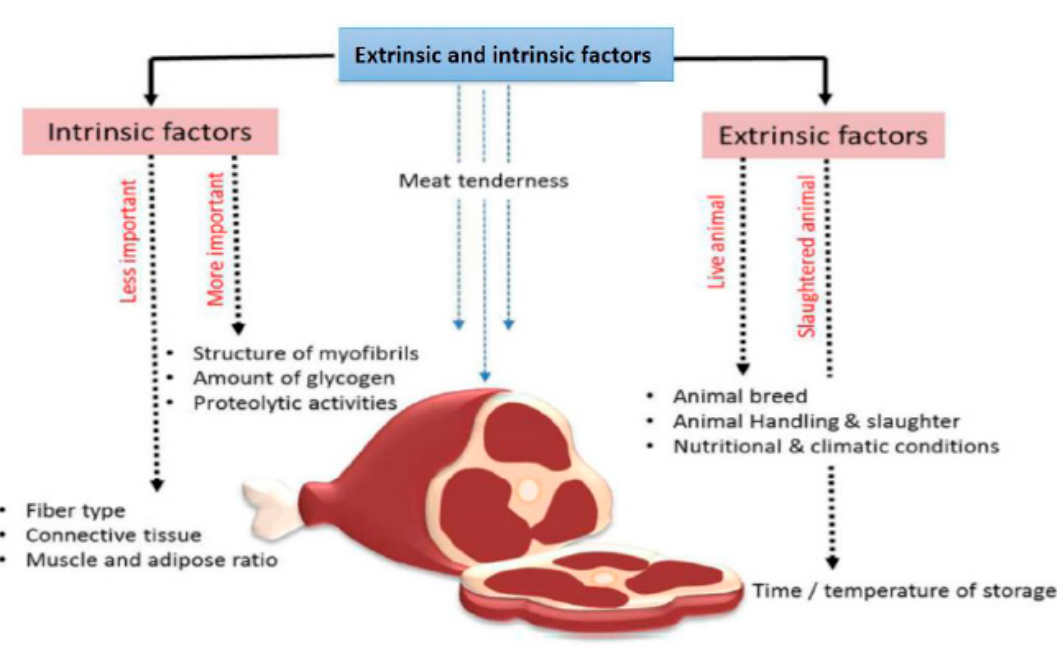
Figure 1. Extrinsic and intrinsic factors a ff ecting meat